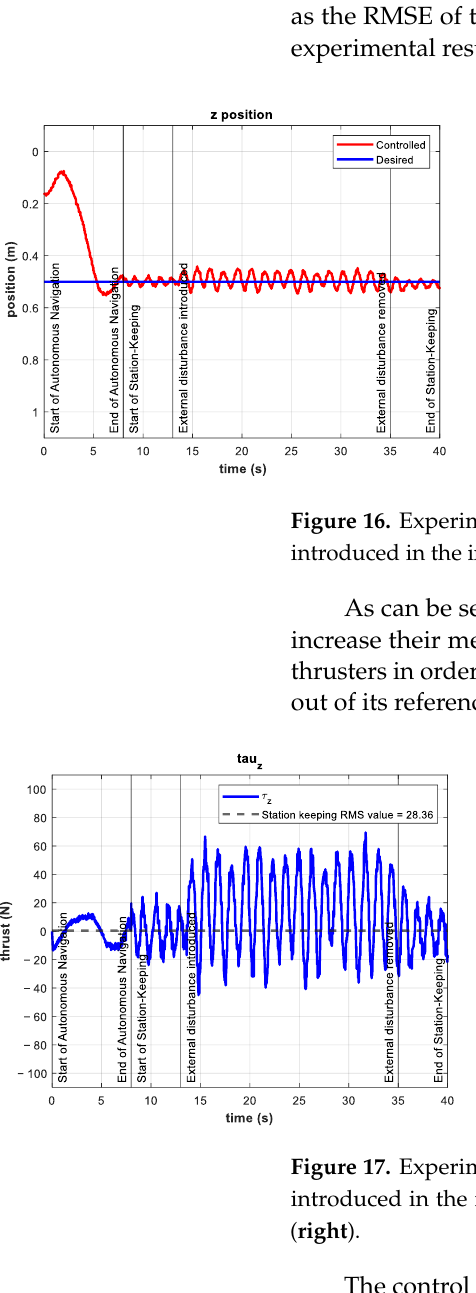
Figure 18. Additional thruster coefficient of −0.50 in the interval 13 s ≤ 𝑡 ≤ 25 s . Some experiments were performed with time-varying external disturbances, such as the one shown in Figure 19.